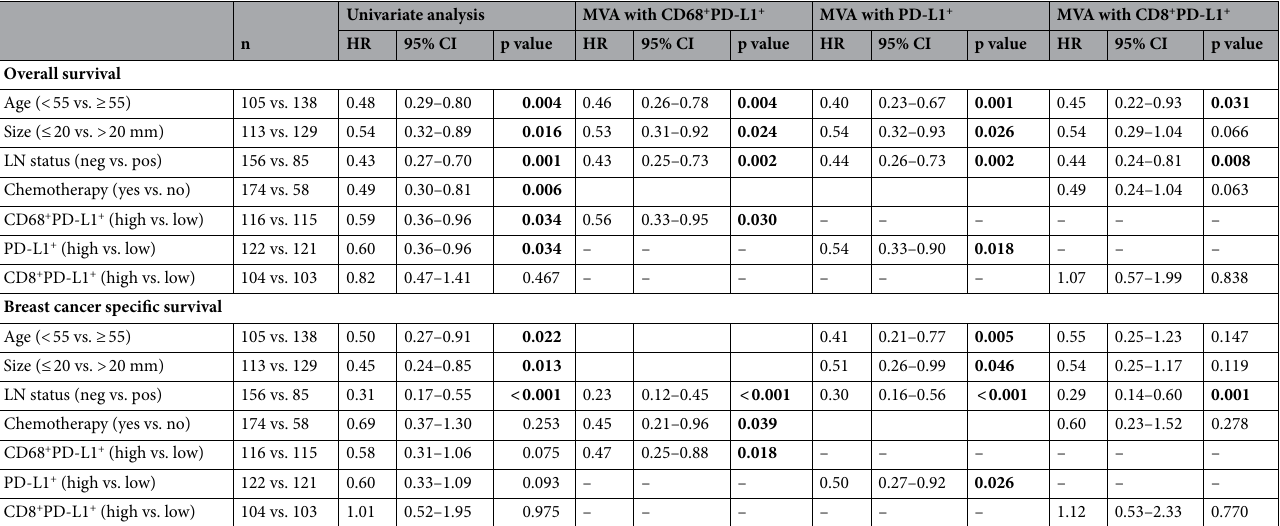
Table 3. Survival models for CD68 + PD-L1 + and CD8 + PD-L1 + for all patients. LN, lymph node; MVA, multivariate analysis. Univariate and multivariate Cox regression models using a p value threshold of 0.05 for statistical significance, which are labelled in bold. Some multivariate models may not feature all significant p values, [–] indicates the immunophenotype was not